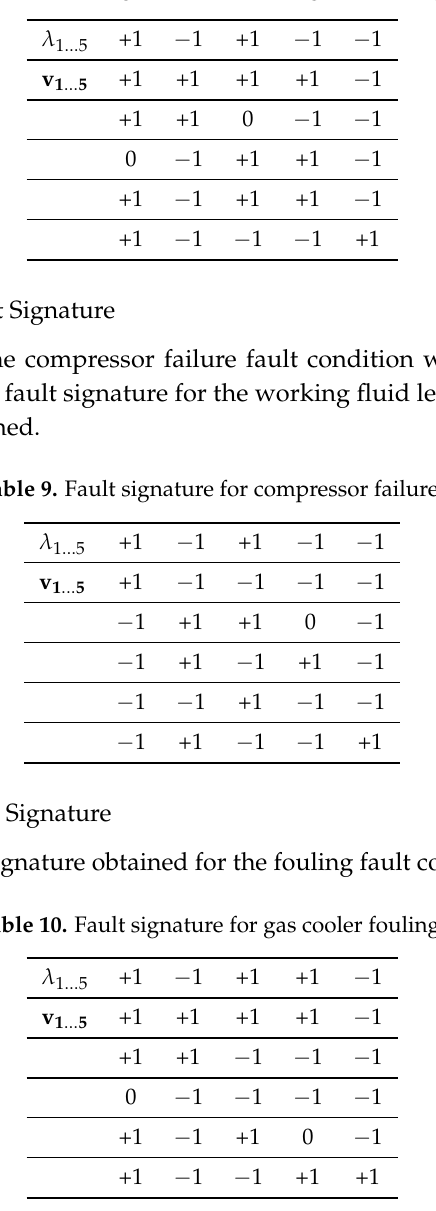
Table 8. Fault signature for working fluid leakage.